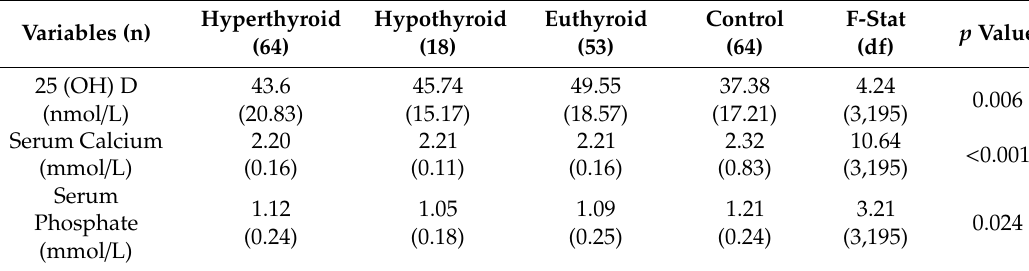
Table 4. ANOVA analyses. Comparisons of the mean serum 25(OH)D, serum calcium and serum phosphate in between groups.